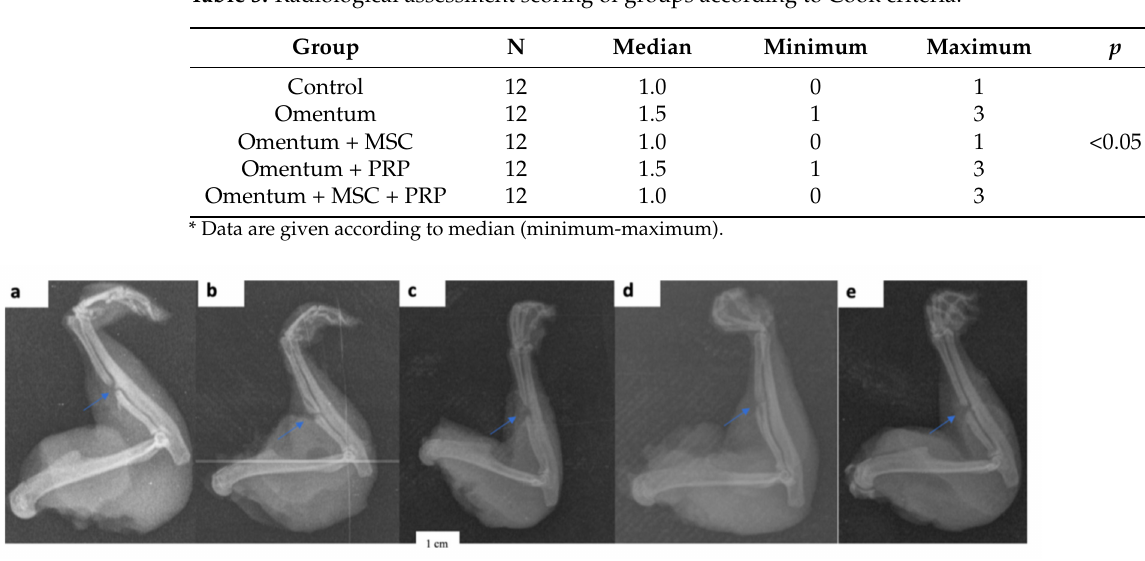
Table 3. Radiological assessment scoring of groups according to Cook criteria.